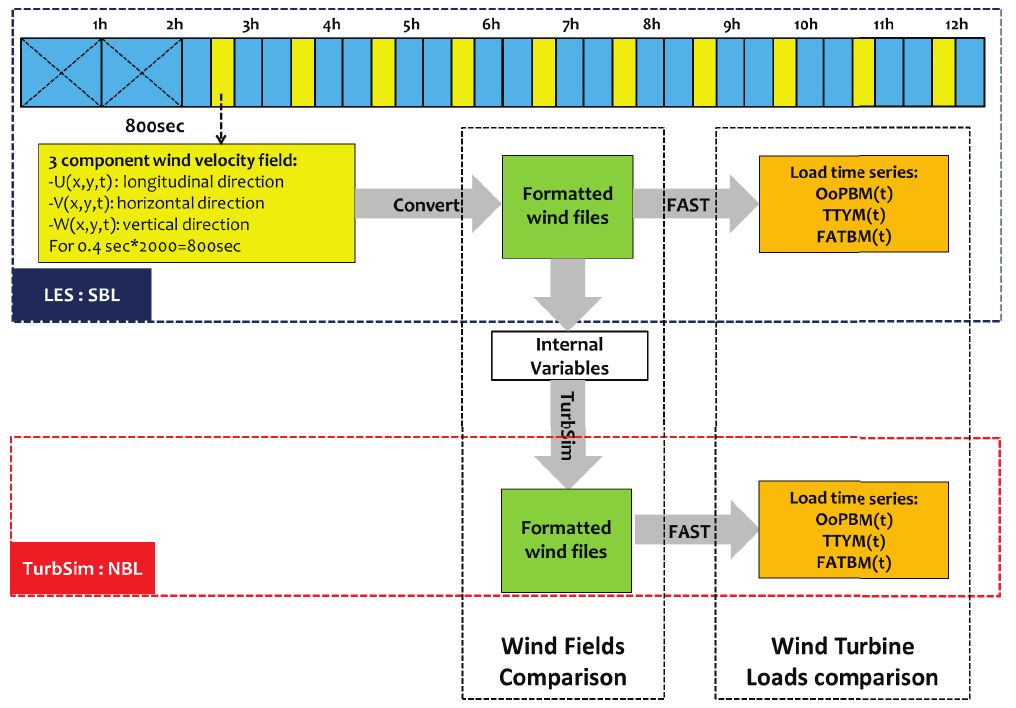
Figure 1. Procedure for comparing two wind field simulation methods in wind turbine loads